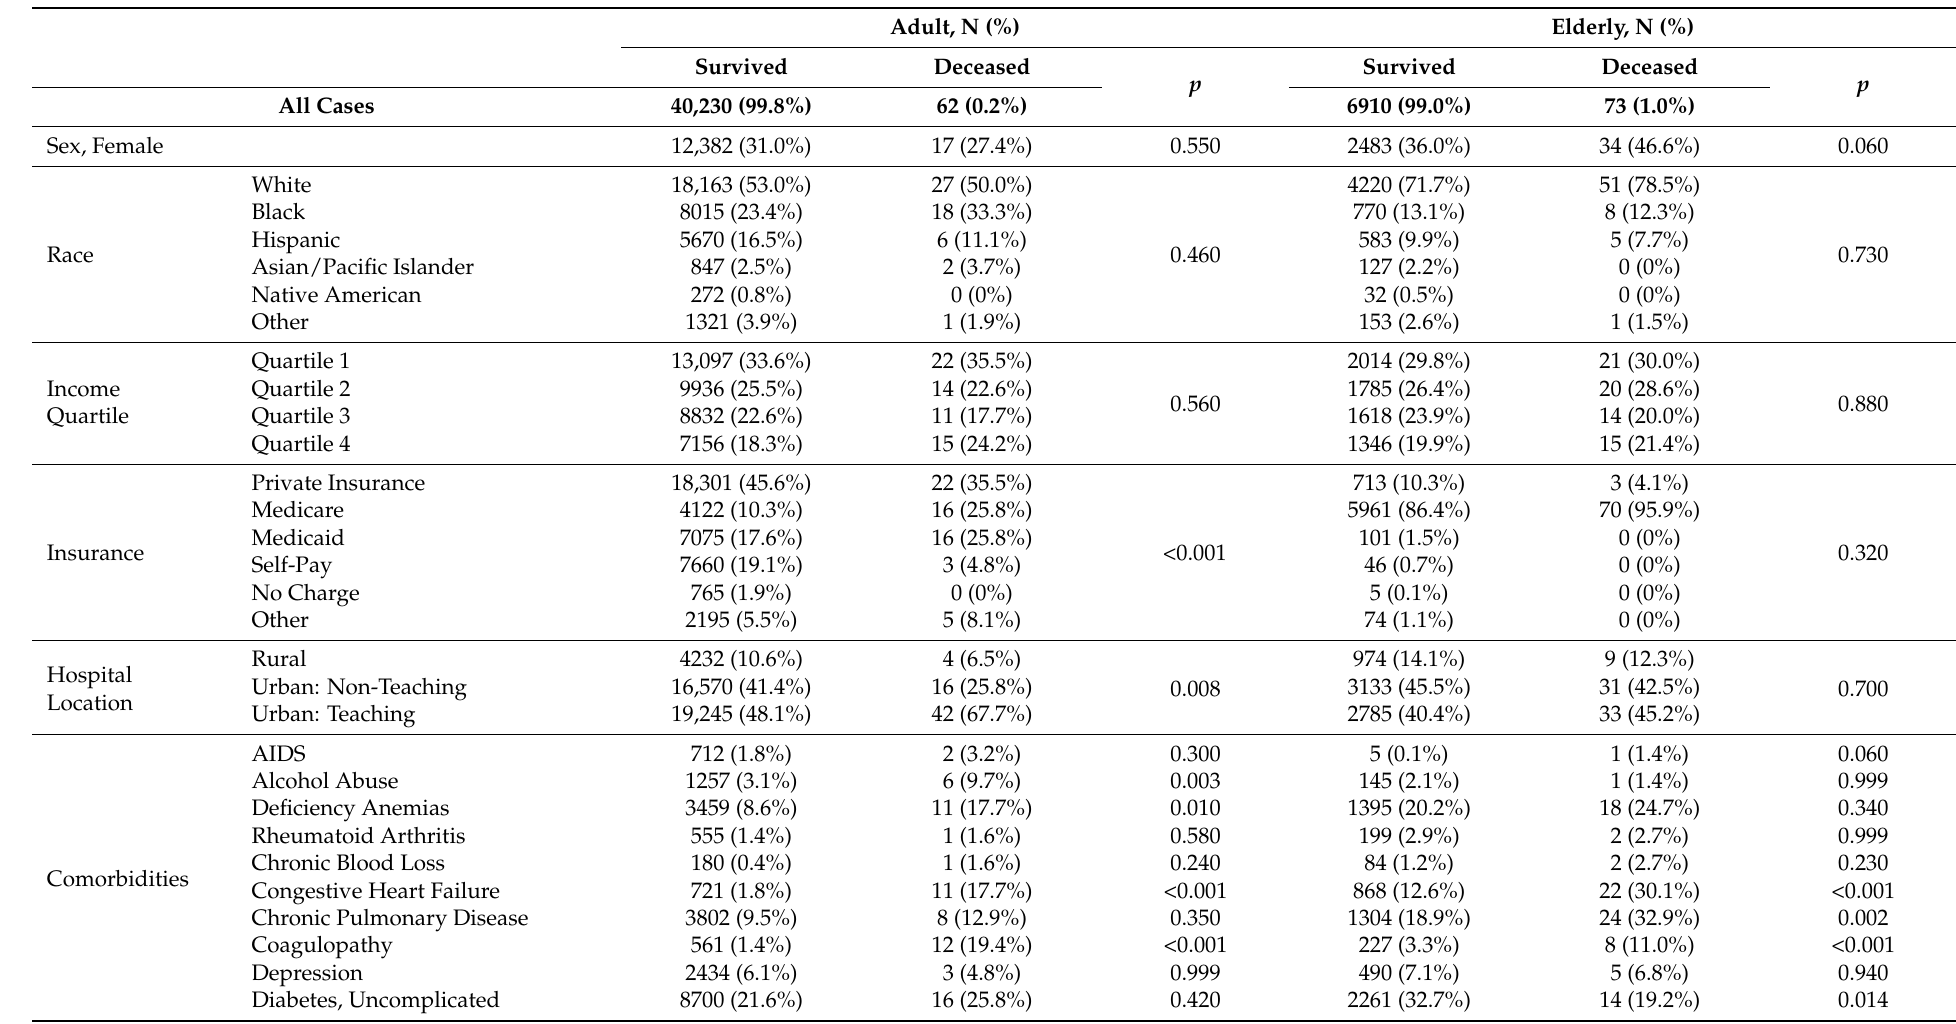
Table 3. Characteristics of emergently admitted patients with the primary diagnosis of abscess of anal/rectal regions. Data are classified according to outcome categories, NIS